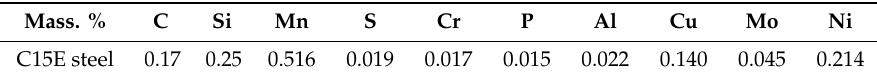
Table 1. Chemical composition of C15E